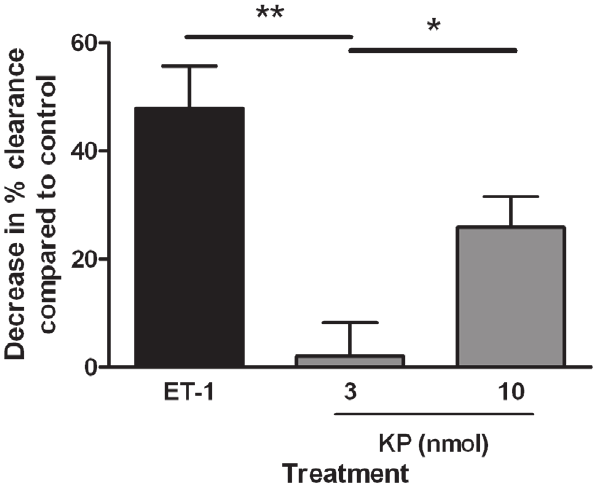
Figure 6. Kisspeptin-10 decreases blood flow in the peripheral vasculature. Male and female CD1 mice were anaesthetised, injected intradermally via the dorsal skin with 3 or 10nmol KP-10 (KP) or 30pmol Endothelin-1 (ET-1), each containing an equal amount of 99m Tc. Clearance after ten minutes was assessed and compared to total radioactivity in an uninjected sample. Saline vehicle was adjusted to 100% and results displayed as a % change to controls. Results are shown as mean 6 SEM, N =5. *=p # 0.05, **=p # 0.01 as assessed by two-tailed Student’s t-test.